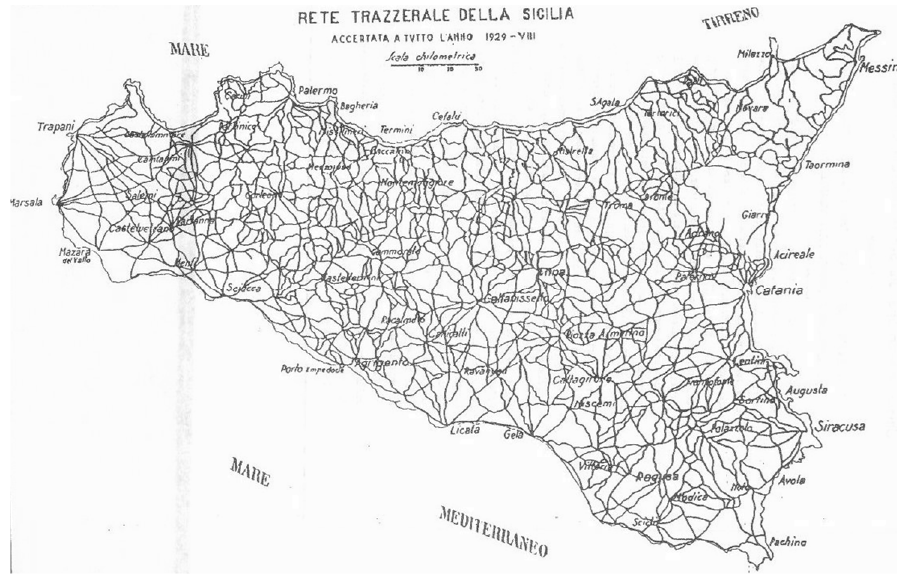
Figure 1. The Trazzera state property in 1929. Source [2].